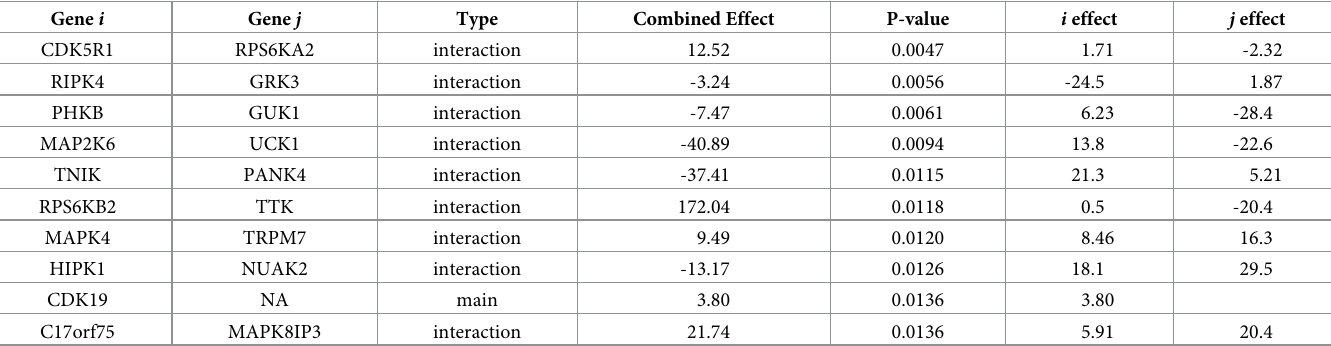
Table 1. Ten most significant predicted effects of siRNA perturbation screens, targeting all human kinases. Gene